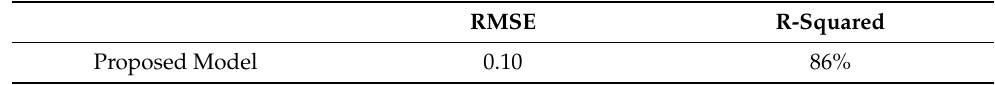
Table 1. Results of the proposed model with RMSE and R-Squared.